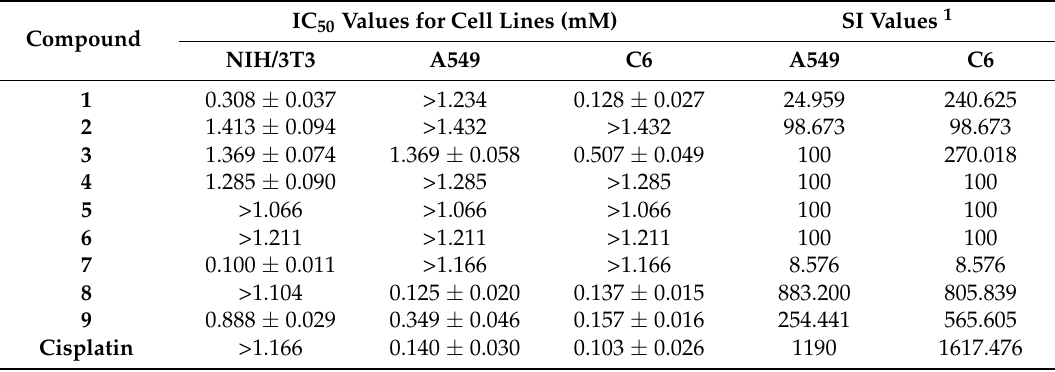
Table 1. Cytotoxic effects of compounds 1 – 9 and cisplatin on A549, C6, and NIH/3T3 cells.